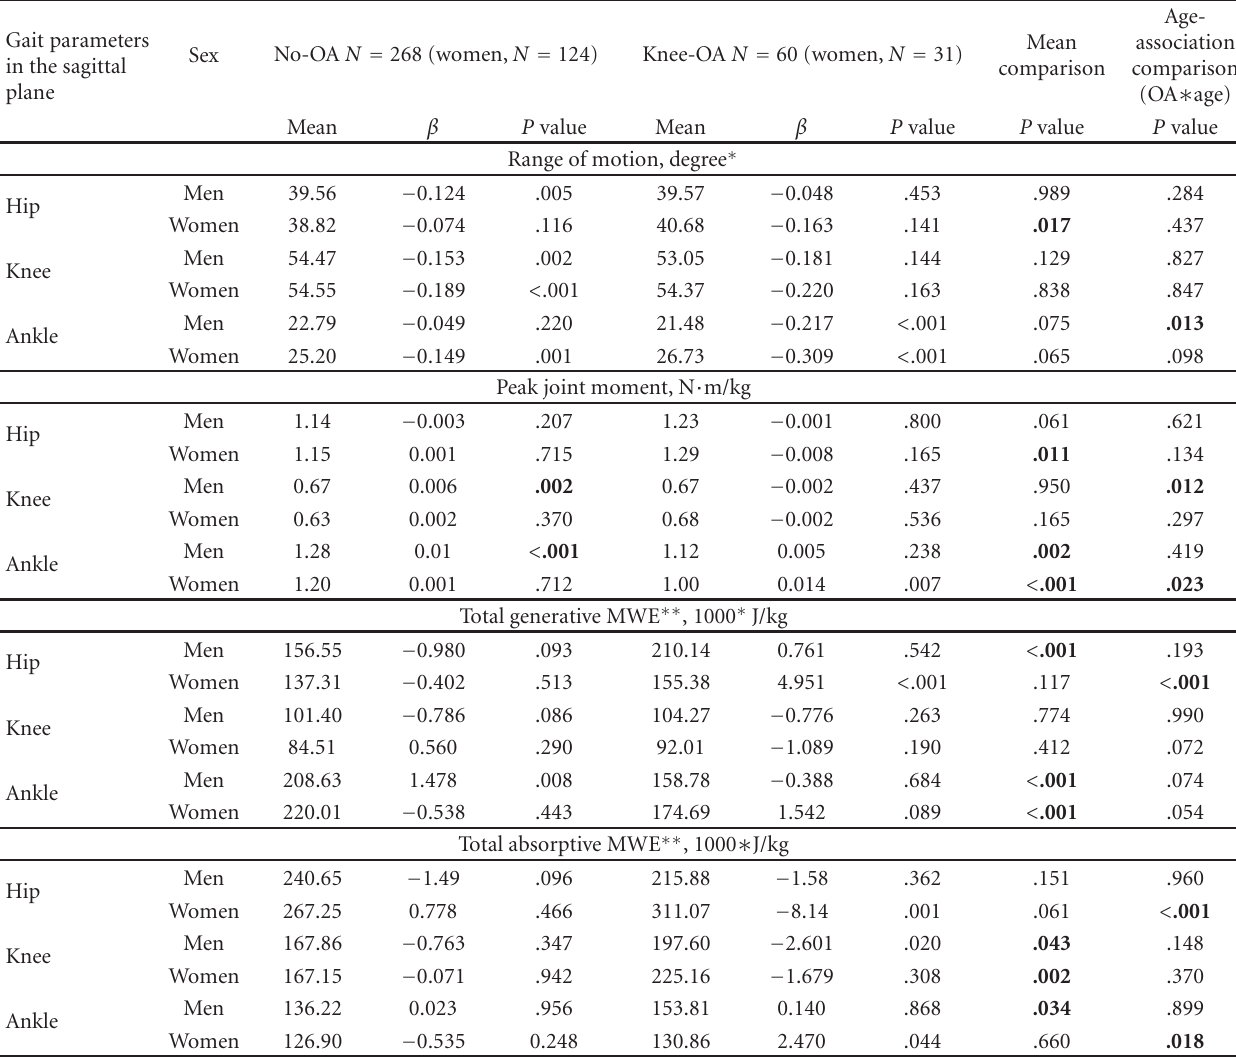
Table 3: Gait kinematic and kinetic parameters in the sagittal plane for men and women with and without knee-OA. Gait parameters in the